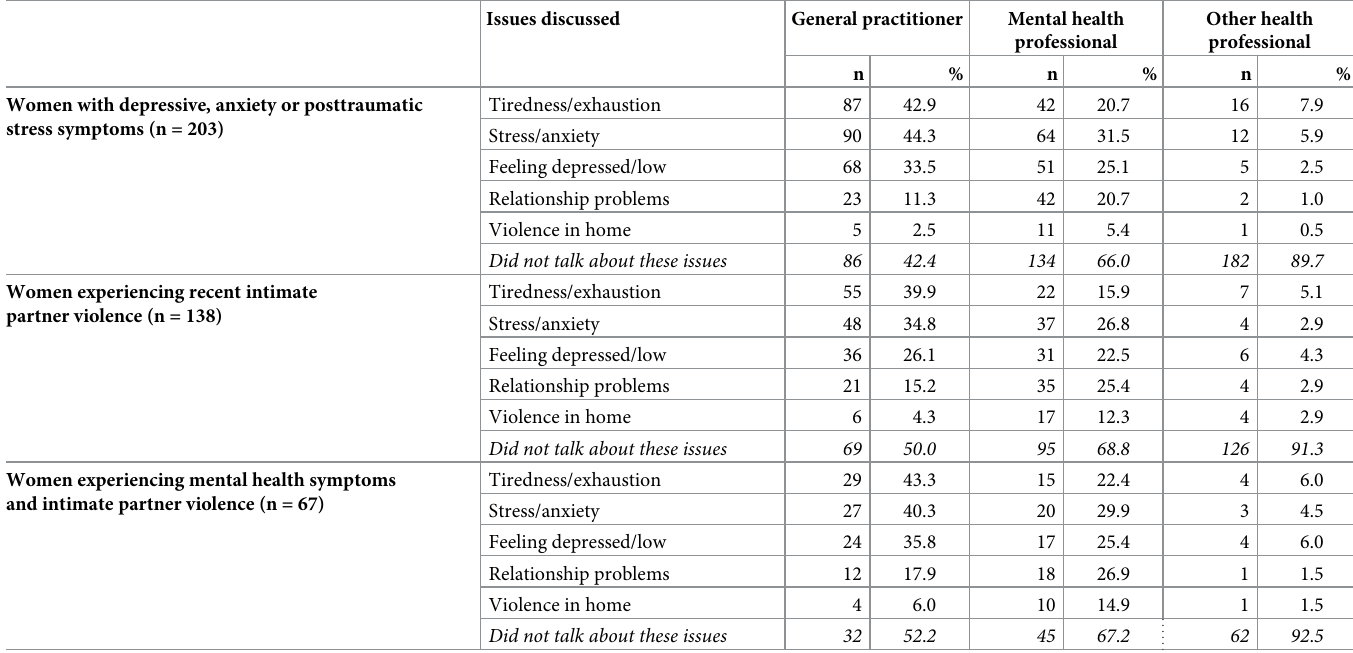
Table 4. Issues discussed with health professionals in the year prior to 10-year follow-up (n = 952) � .